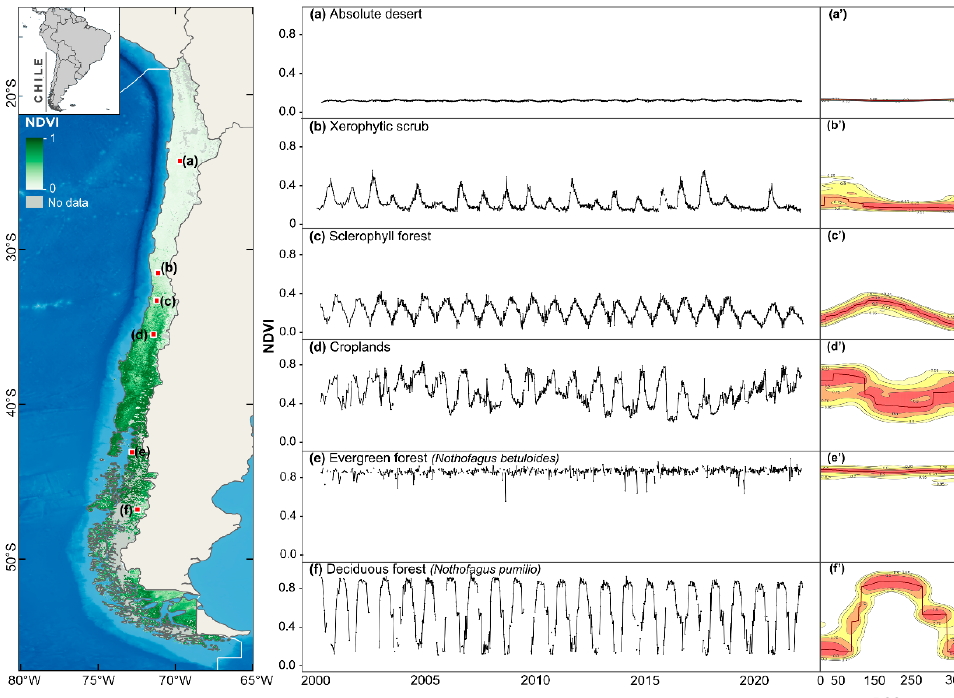
Figure 2. NDVI time series at different locations in Chile ( a – f ) and kernel density estimations (KDE) of the annual phenology ( a’ – f’ ) considering 22 years of MOD/MYD13Q1 NDVI records from the Terra and Aqua satellites. The KDE shows in yellow to red gradient colors the frequency of NDVI values at different days of the growing season (DGS). NDVI values in the map on the left correspond to a MYD13Q1 NDVI image of January 2022 (the peak of the growing season).